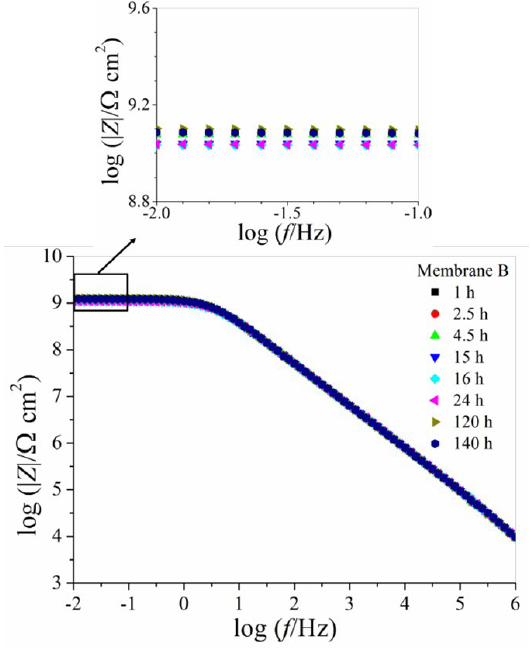
Figure 7. Impedance modulus |Z| Bode plots for the membrane B obtained in 0.1 mol/L KCl, with 100 mV (rms) amplitude and permeation cell.